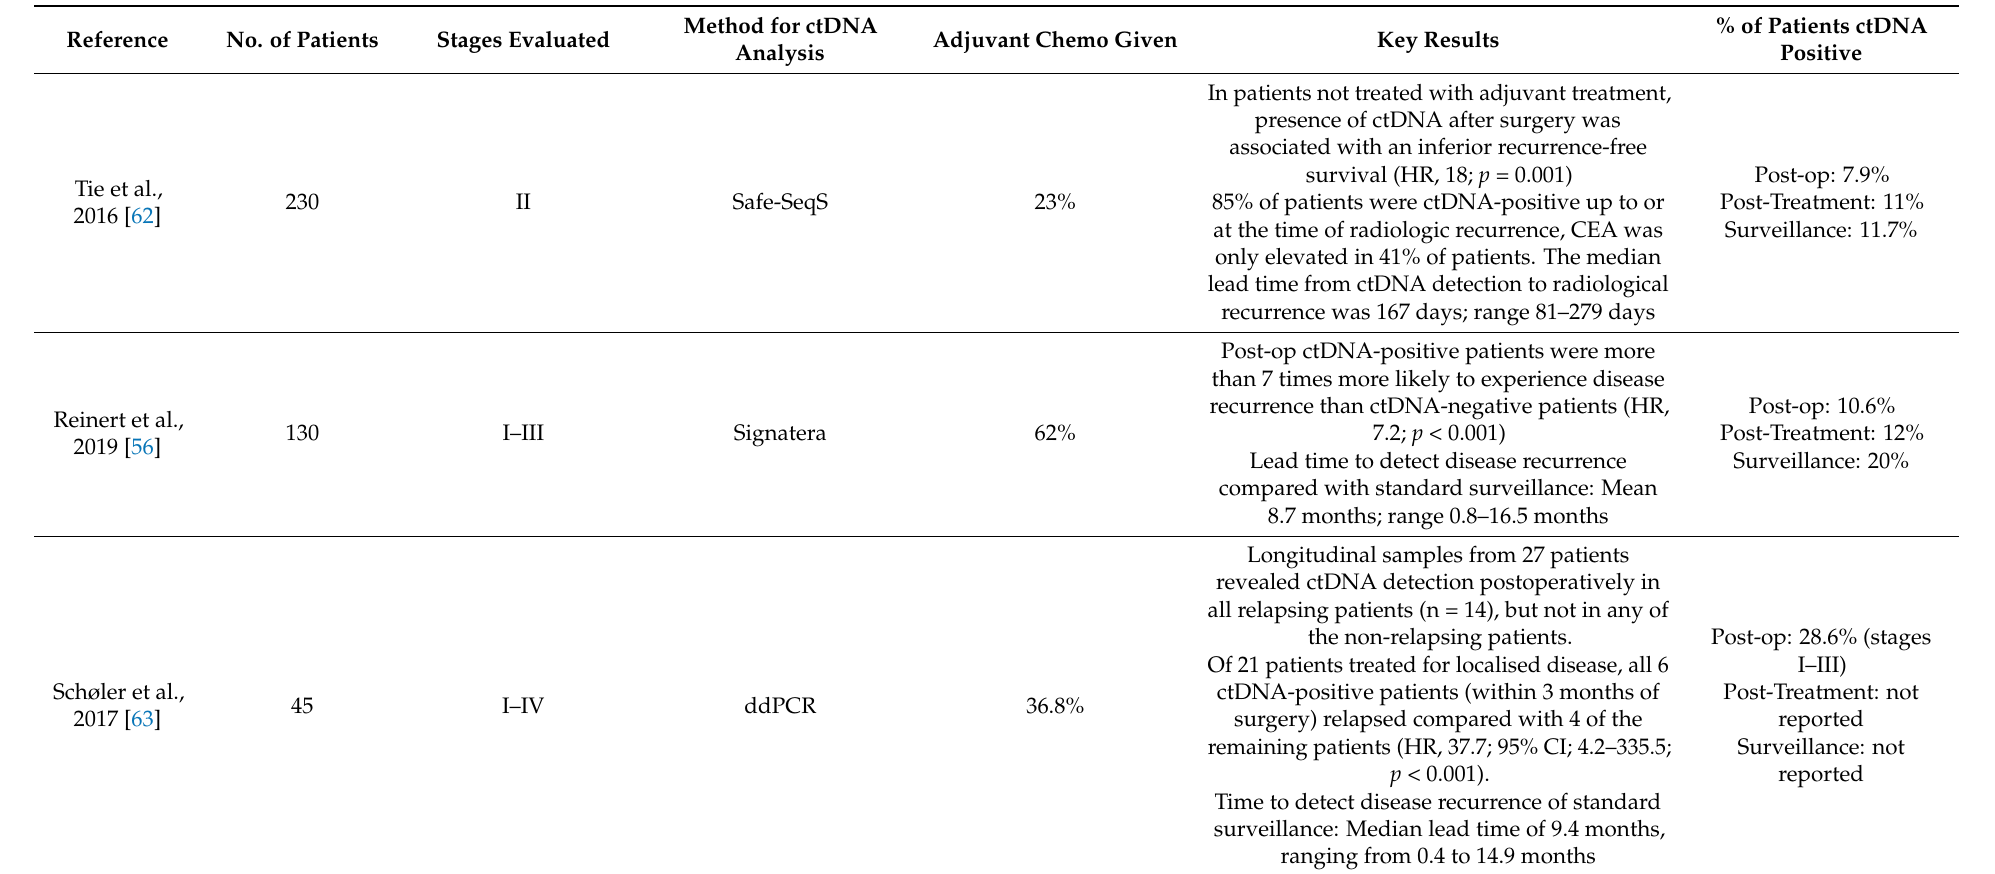
Table 1. Completed observational ctDNA studies in non-metastatic/oligometastatic